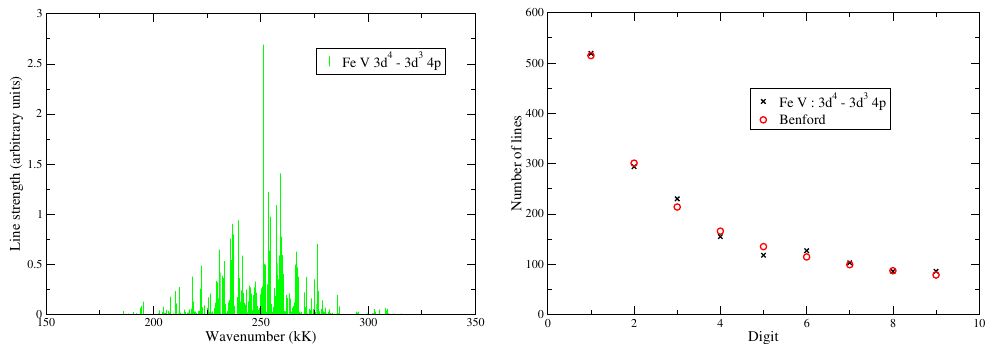
3 d 3 4 p (line strength as a function of energy) computed with Cowan’s Figure 8. Transition array 3 d 4 − code [56] and number of lines as a function of the first significant digit in the value of the strength.